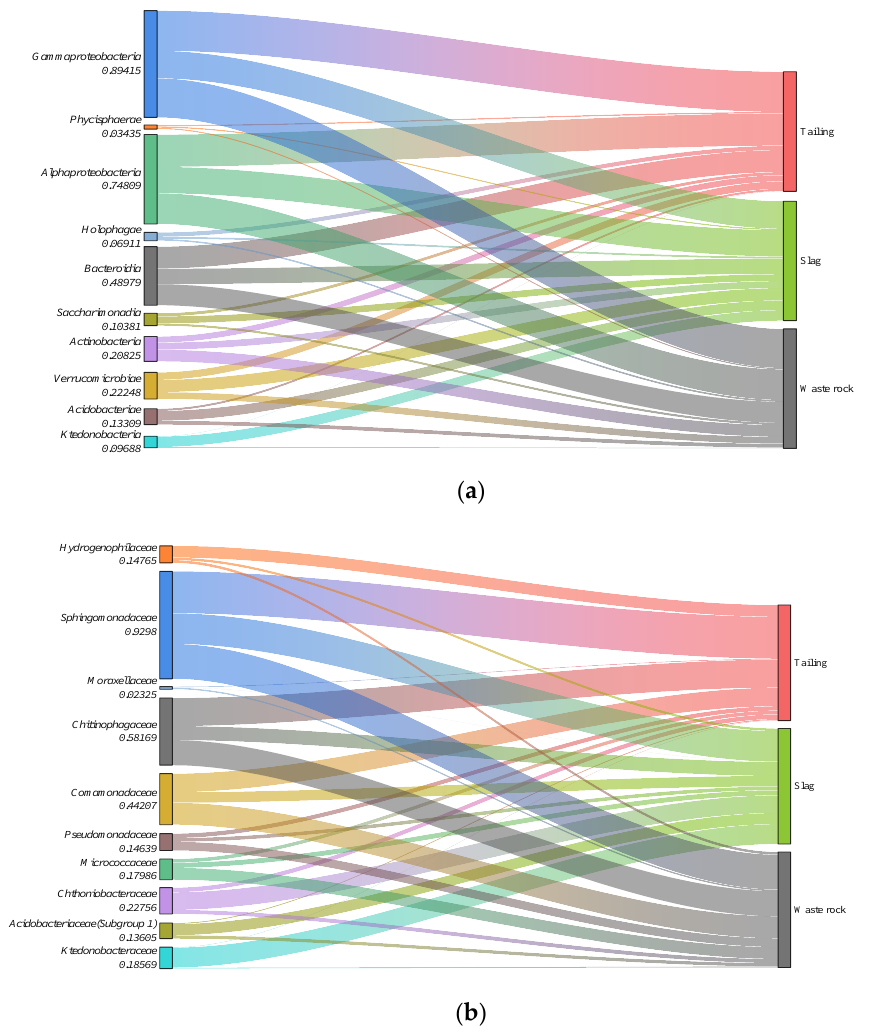
Figure 6. Sankey diagram of the composition of the rhizosphere microbial communities of three mine waste plants (only the top ten microorganisms in relative abundance are listed: ( a ): Class level; ( b ): Family